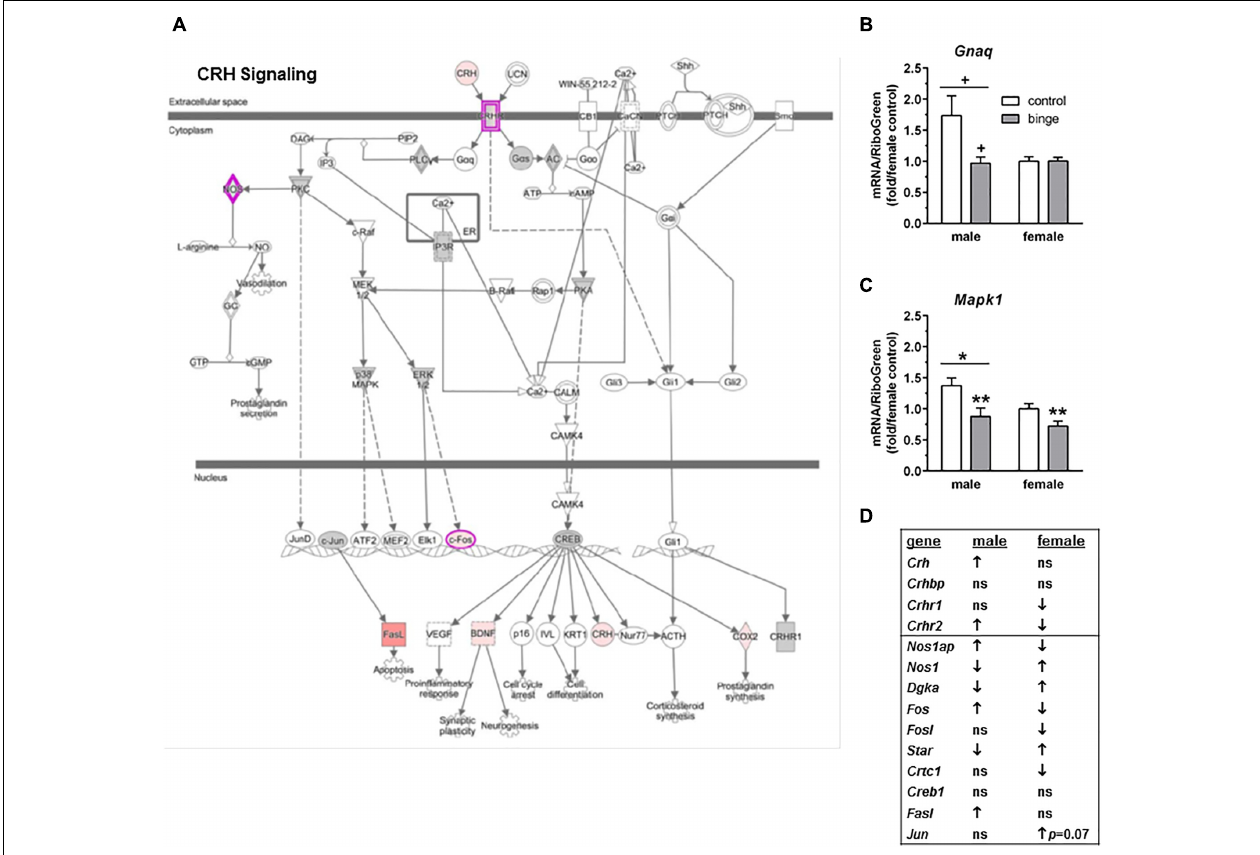
FIGURE 3 | Simplified corticotropin releasing hormone (CRH) signaling pathway highlights genes influenced by repeated binge drinking in male and female mice. This canonical pathway was identified by IPA as regulated by binge drinking in both males and females. (A) Depicts the CRH signaling pathway and highlights genes regulated by binge drinking in males (pink for up-regulation, green for down-regulation). (B,C) Depict qRT-PCR results and show that expression of Gnaq ( B which encodes G α q) tended to be higher in males vs. females and to be decreased by binge ethanol drinking in males. Expression of Mapk1 ( C which encodes Erk2) was significantly higher in males vs. females and was significantly decreased by binge drinking in both sexes. Values are the mean ± SEM for 4/sex/treatment. + p < 0.07 vs. respective control in males or sex difference (over horizontal line); ∗ p < 0.05 for main effect of sex (over horizontal line), ∗∗ p < 0.01 for main effect of treatment. (D) Shows significant regulation by binge drinking of select genes from the qPCR array analysis that are pertinent to the CRH signaling cascade depicted in (A) for male and female mice ( ↑ for up-regulation, ↓ for down regulation; p < 0.05 at a minimum). For statistical trends, the p -values are provided. Gnaq (guanine nucleotide binding protein, alpha q polypeptide) encodes the protein G α q. Mapk1 (mitogen-activated protein kinase 1) encodes the protein ERK2 (extracellular signal-regulated